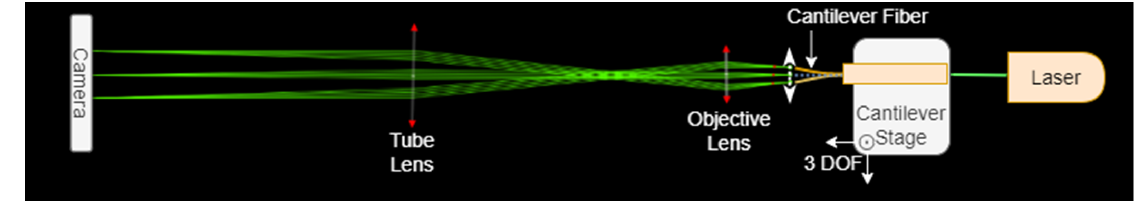
Figure 3. Ray diagram of the optical setup used to capture front light image.